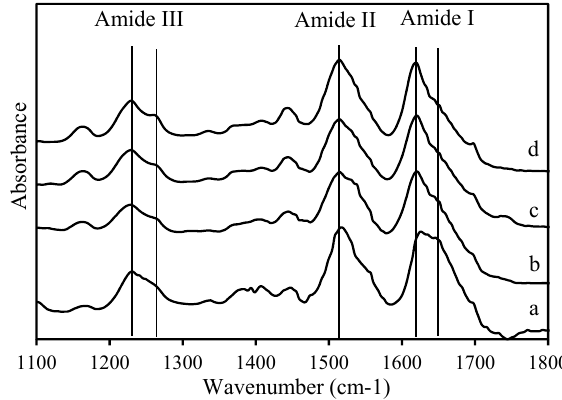
Figure 7. ATR- FTIR spectra of the RS powder, resin, and rolled resin: (a) the RS powder, (b) the original RS resin, (c) the RS hot-rolled resin without the boiling treatment, (d) the RS hot-rolled resin with the boiling treatment.